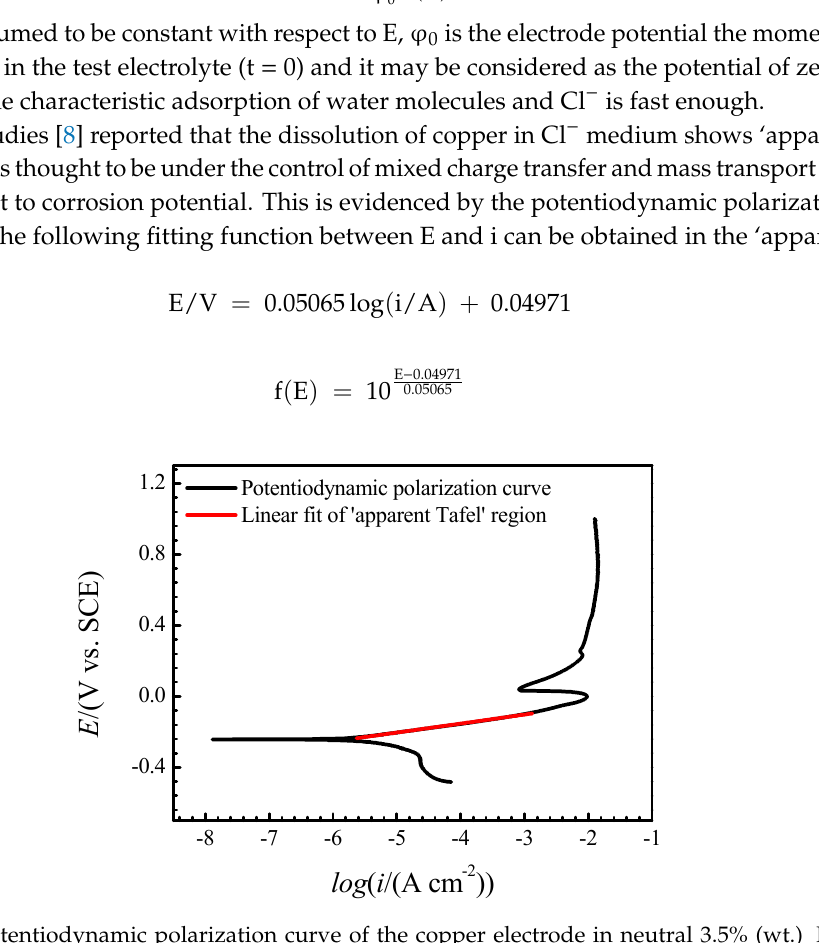
Figure 5. Experimental OCP diagram of copper electrode in neutral 3.5% (wt.) NaCl solution at room temperature during the 1st h ( a ) and corresponding theoretical one ( b ).